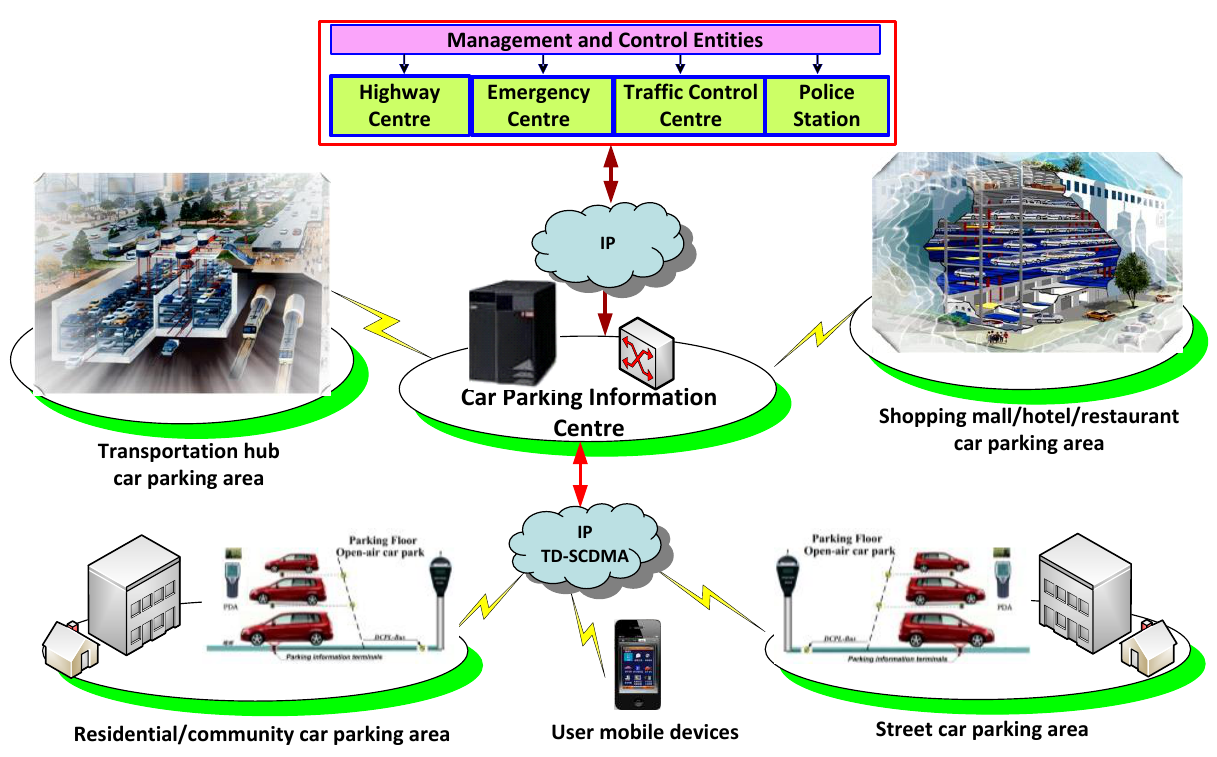
Figure 5. The intelligent car parking services’ operational